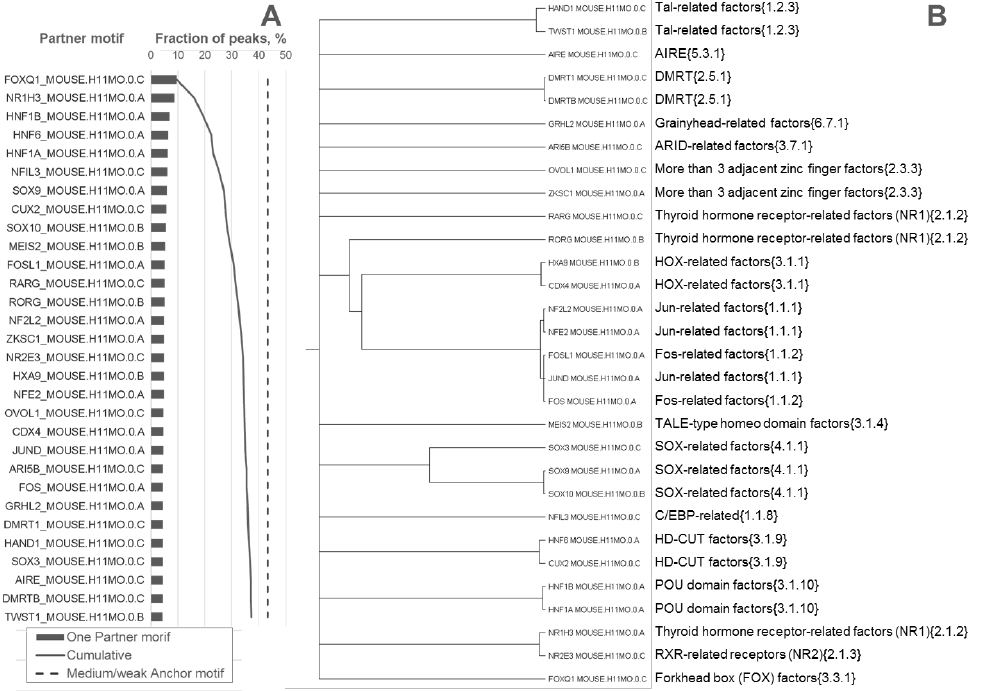
Figure 3. The analysis of FoxA2 peaks [15] that contained the FoxA2 motifs of moderate and weak conservation. Panel ( A ) displays fractions of analyzed peaks that contained asymmetric CEs with specific partner motifs. Panel ( B ) shows the tree of similarity for the selected list of the 30 top-ranked partner motifs from panel A and the respective families of partner transcription factors (TFs) [13]. We took in an analysis of only 43.21% of all peaks with the best scores of peaks in the range of FPR from 5.24 × 10 −5 to 5 × 10 −4 , see the dashed line in panel ( A ). We applied MCOT package and defined the top-ranked 30 partner motifs from the Hocomoco mouse core collection [14] that did not have a similarity to the anchor motif ( p < 0.05, any similarity measure from [11]) and respected the significant asymmetric CEs toward the partner motif. We sorted partner motifs according to the fraction of peaks that contained such asymmetric CEs and computed the cumulative fraction of peaks that contained at least one, two, three, etc., up to 30 types of CE types with various top-ranked partner motifs, see the regular line in panel ( A